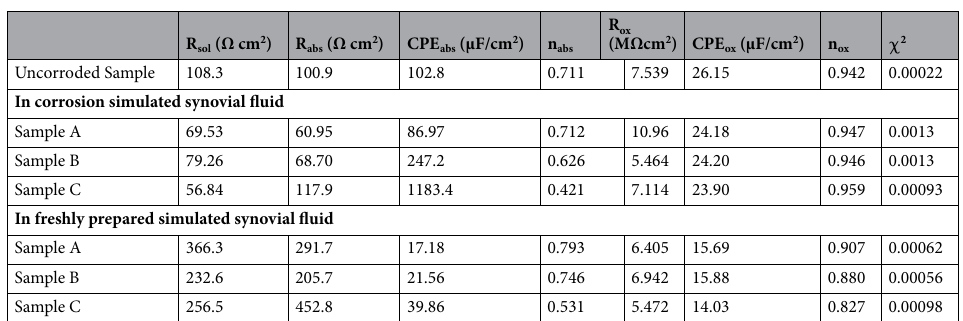
Table 5. Equivalent circuit parameters of CoCrMo under the studied corrosion environments as symmetric cells. R sol , solution resistance/solution interaction resistance with absorption layer, R abs , absorption/outer layer resistance, CPE abs , calculated capacitance of the constant phase element for the absorption/outer layer, R ox , oxide/inner layer resistance, CPE ox , calculated capacitance of the constant phase element for the oxide/inner layer, n, the exponent of the